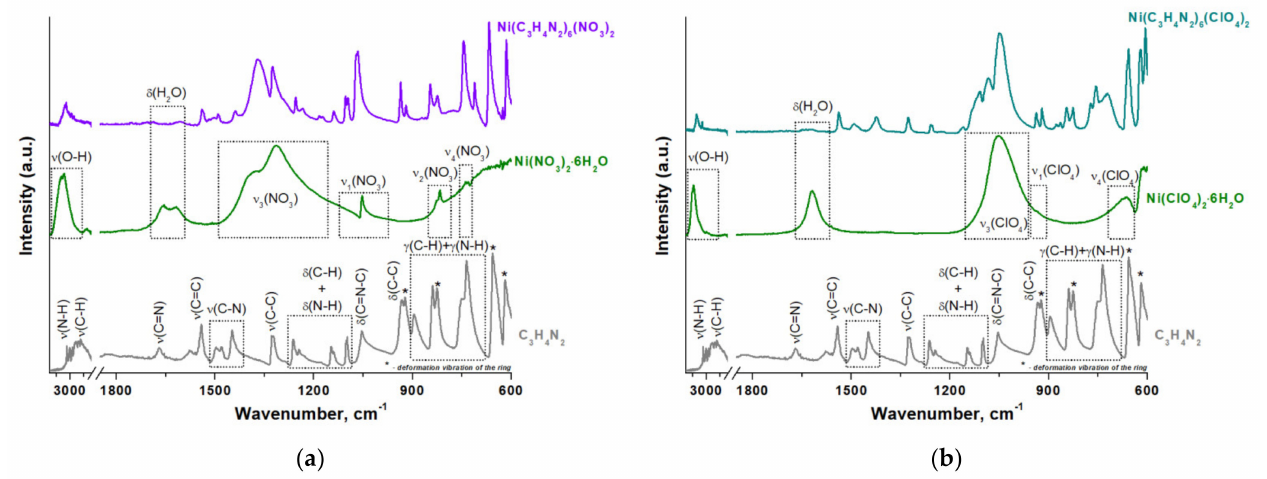
Figure 2. ATR FTIR spectra for synthesized ( a ) [Ni(C 3 H 4 N 2 ) 6 ](NO 3 ) 2 and ( b ) [Ni(C 3 H 4 N 2 ) 6 ](ClO 4 ) 2 complexes (*—deformation vibration of the ring).